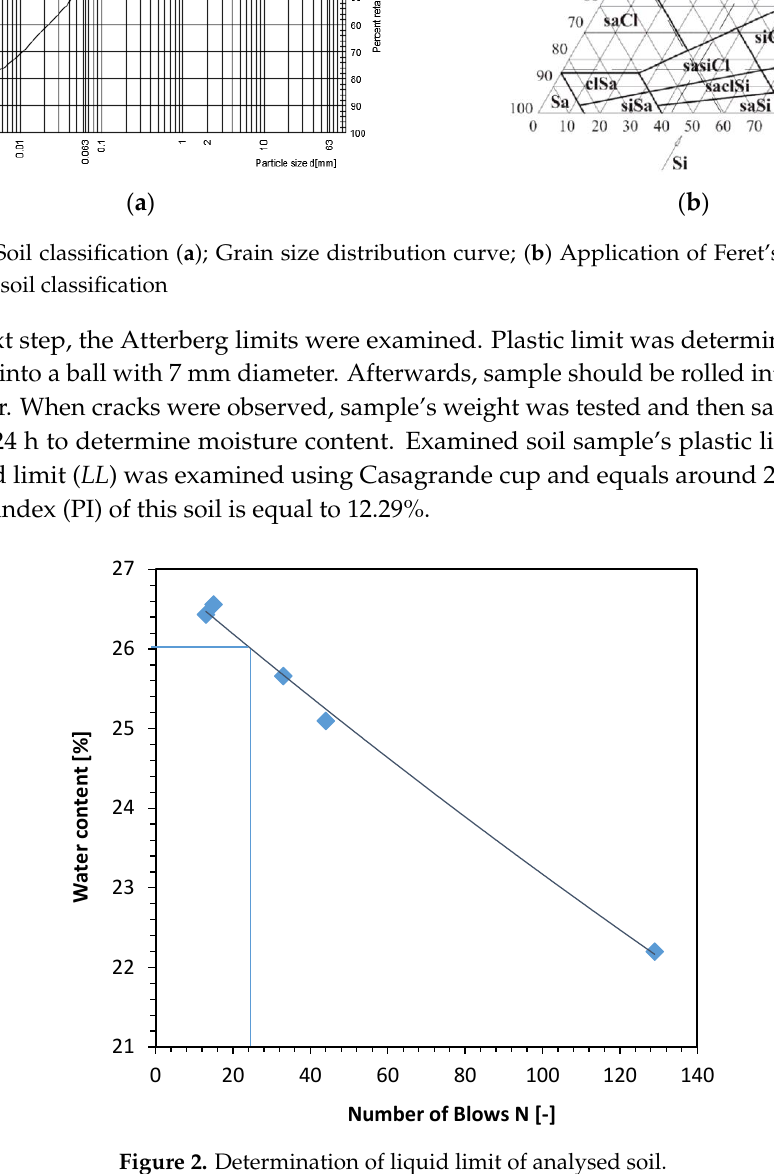
Figure 2. Determination of liquid limit of analysed soil.